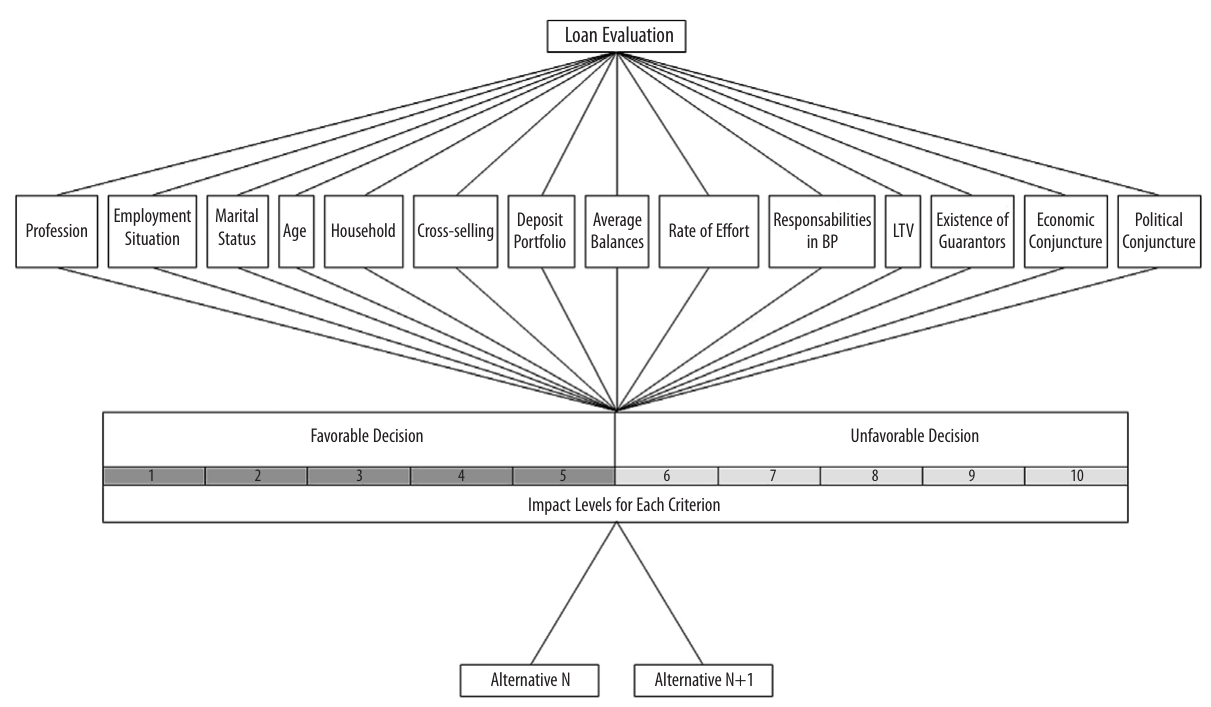
Fig. 2. Structure of evaluation criteria and respective impact levels Source : Own elaboration (based on administrative